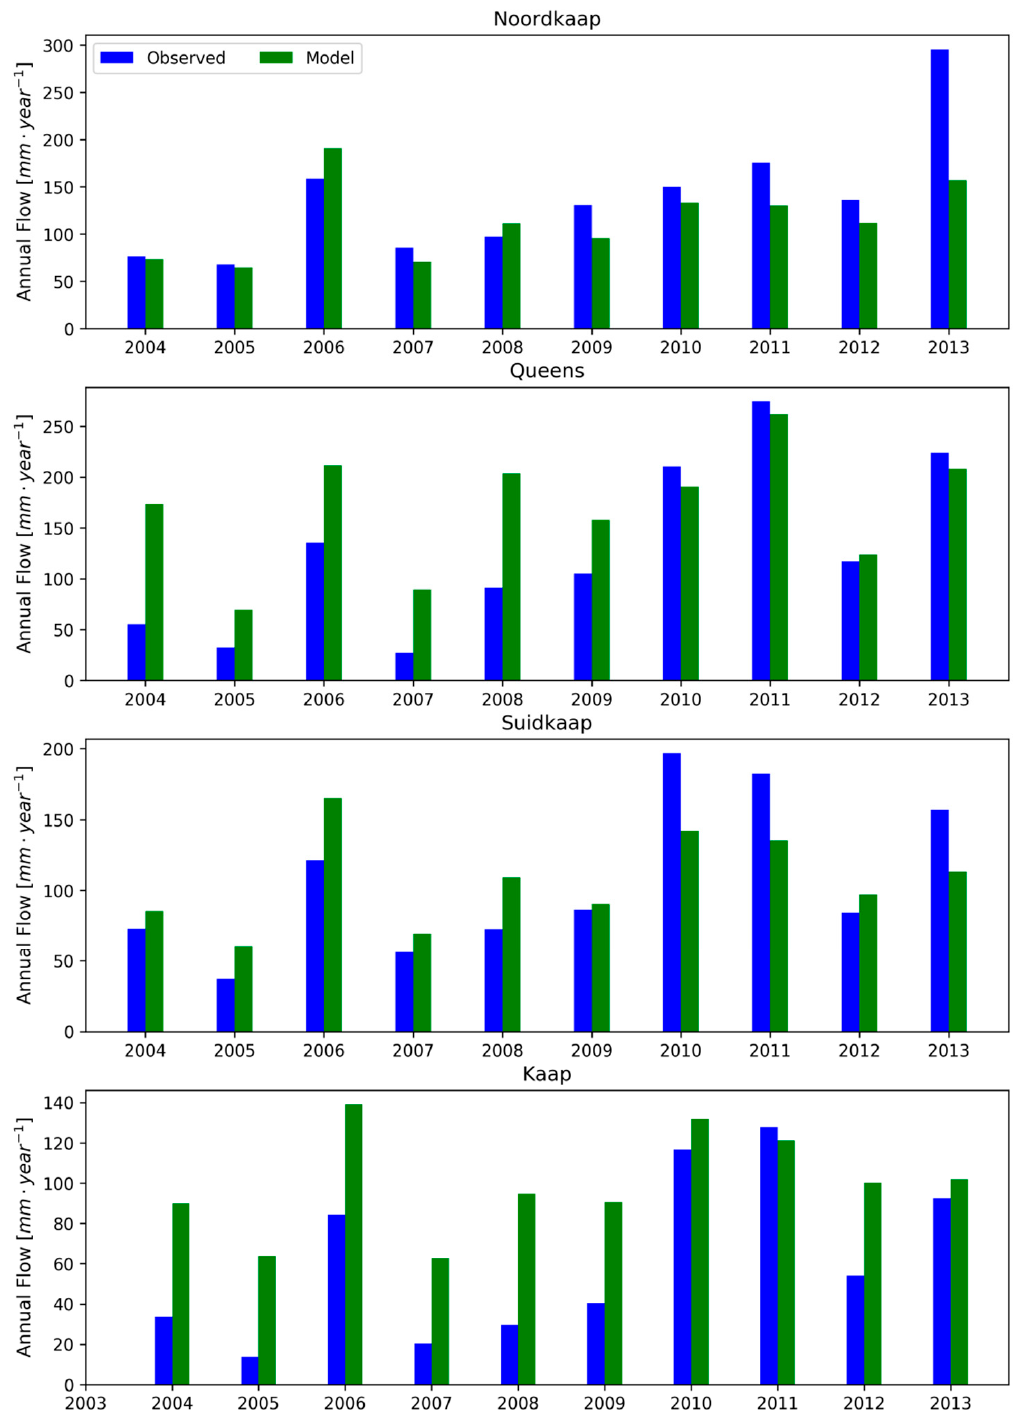
Figure 5. Annual Flow for the four catchments, using results of run 64.